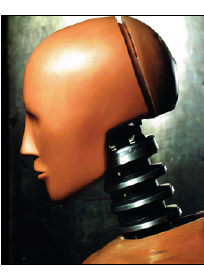
Figure 8 – Neck for crash-test dummies Рис . 8 – Шея манекенов , используемых в дорожно - транспортных краш - тестах Слика 8 – Врат за лутке које се користе при тестирању саобраћајних